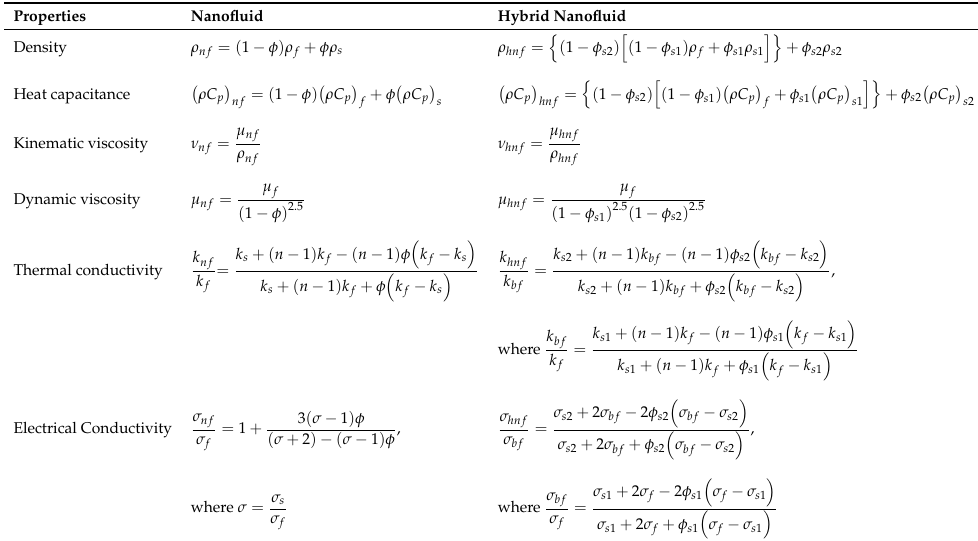
Table 2. Properties of nanofluids and hybrid nanofluids (Devi and Devi [15]).